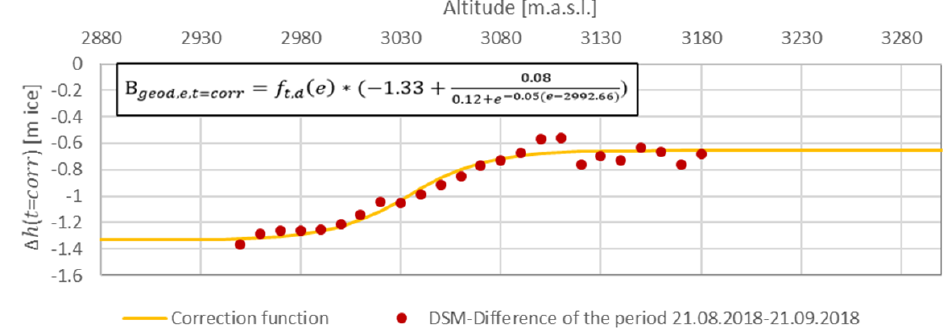
Figure 3. Surface changes in 10m altitude bins for the correction period (21 August 2018 to 21 September 2018, red dots); the regression curve (yellow) represents height changes related to the altitude; SD of the regression is 0.07m